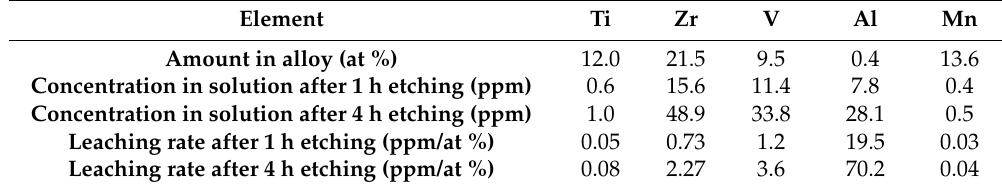
Table 4. Calculation of leaching rate in 100 °C/30% KOH of a C14 MH alloy with a composition of